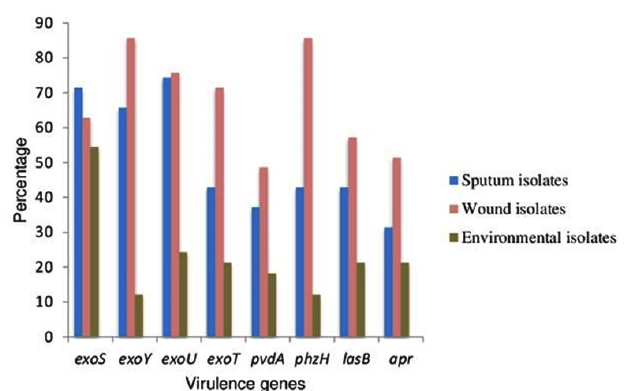
Fig.1. Percent prevalence of virulence genes in clinical and environmental isolates of P. aeruginosa